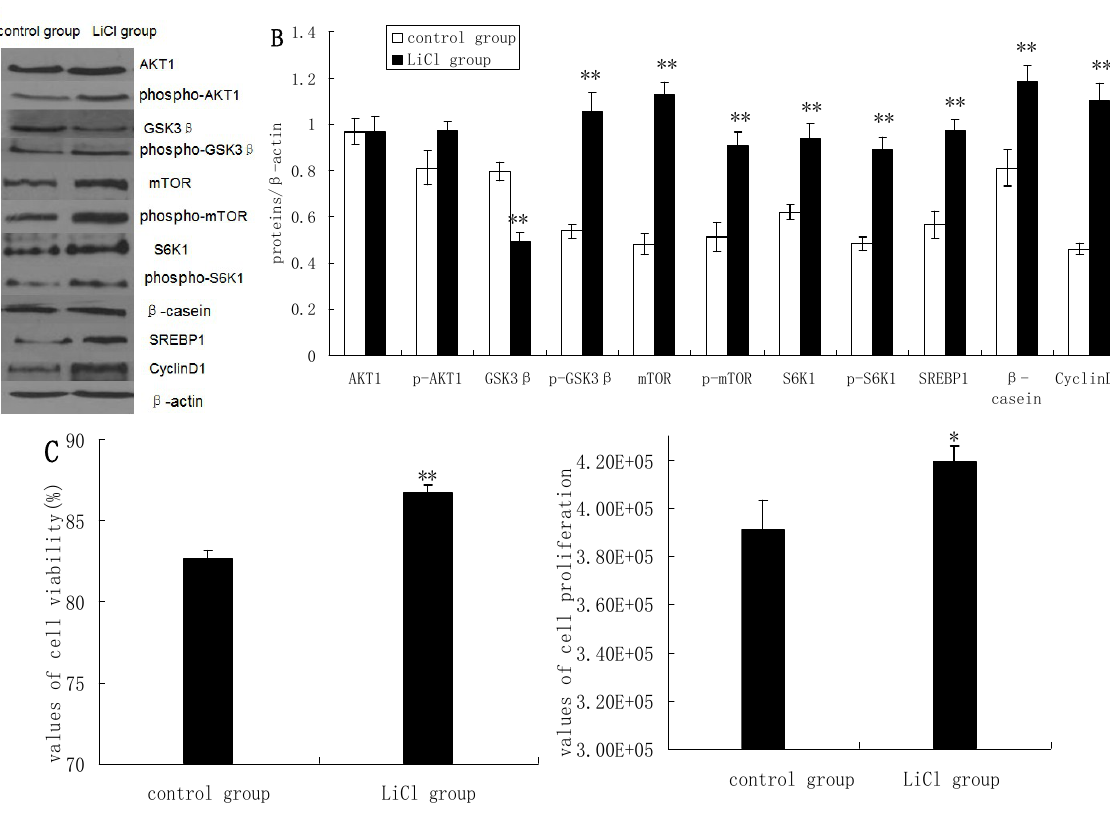
Figure 2. Protein expression, cell proliferation, cell viability, cell cycle, and triglyceride (TG) secretion was assessed in DCMECs treated with LiCl (20 mM) for 24 h and in untreated control cells. Protein expression levels were assessed by western blotting analysis ( A ) and quantified (proteins/ β -actin relative fold) by gray scale scan ( B ). Cell viability and cell proliferation of DCMECs were assessed using a cell counter ( C ) and cell cycle analysis was carried out using flow cytometry ( D ). TG content in the culture supernatant of DCMECs was measured ( E ). All values represent means ± SE ( n = 3 biological replicates). * p < 0.05, ** p < 0.01 compared with untreated control